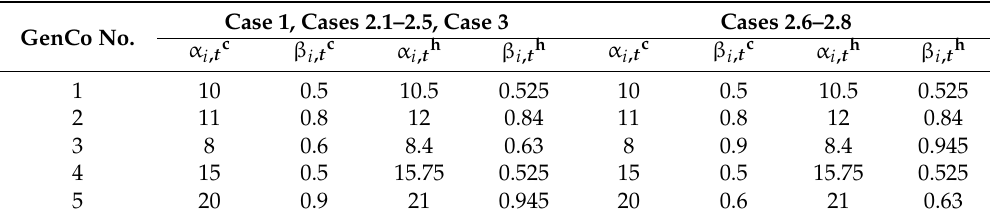
Table 2. Parameters of GenCos’ bidding curves. (Unit for α i , t c , α i , th : $/MW per hour, unit for β i , t c , β i , t h : $/(MW) 2 per hour). GenCo No.